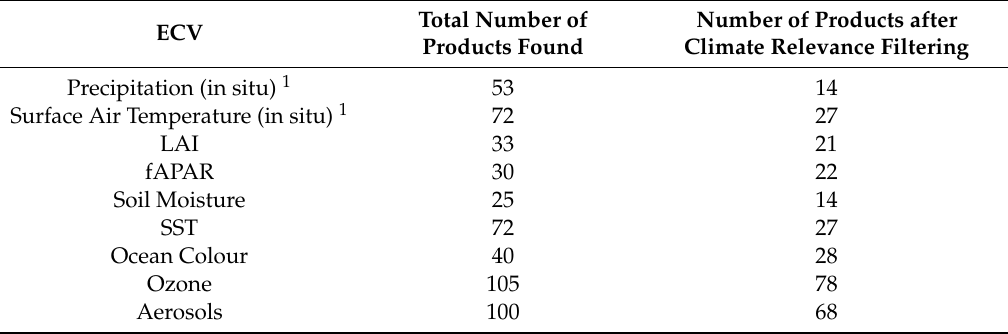
Table 1. Total number of data products found for each of the nine demonstrator Essential Climate Variables (ECVs) and number of products considered to be climate relevant after filtering. Total Number of Number of Products ECV Products Found